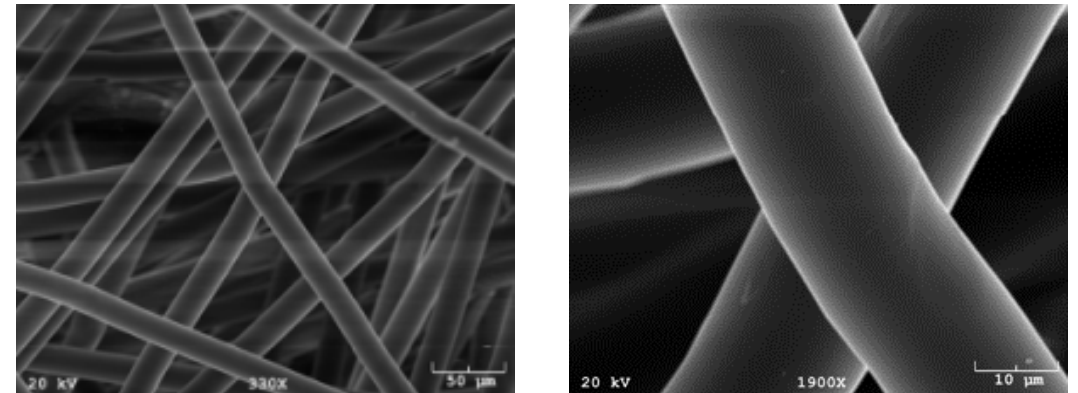
Figure 8. Common synthetic polymeric scaffolds used for tissue engineering. Scaffolds manufactured using spunbonding and imaged using scanning electron microscopy (SEM).